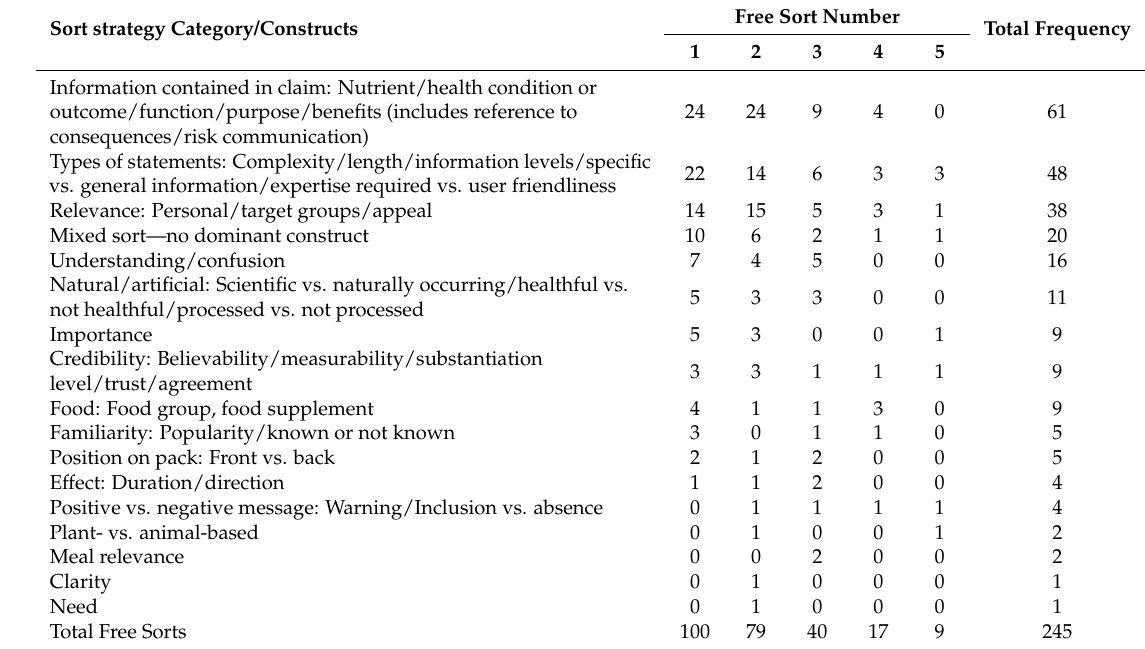
Table A1. Categories of constructs used in free sorting for all countries combined.